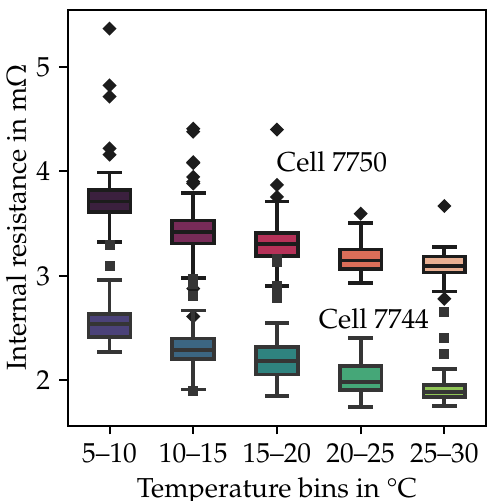
Figure 10. Internal resistance for cell 7744 and 7750 over the temperature. As expected, lower temperatures yield to higher impedance.